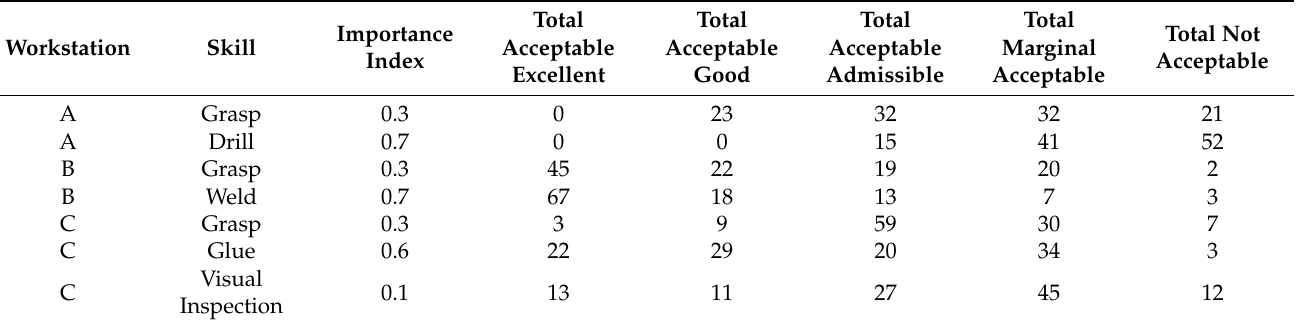
Table 6. Implementation data assignment which shows the count of tested skills during the specified